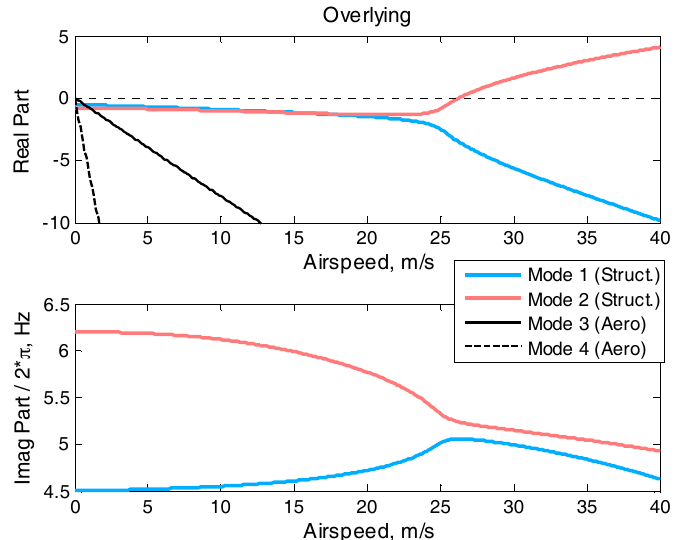
Figure 12. Eigenvalues of the overlying linear system (OLS) of the wing section model varying with the flow velocity.